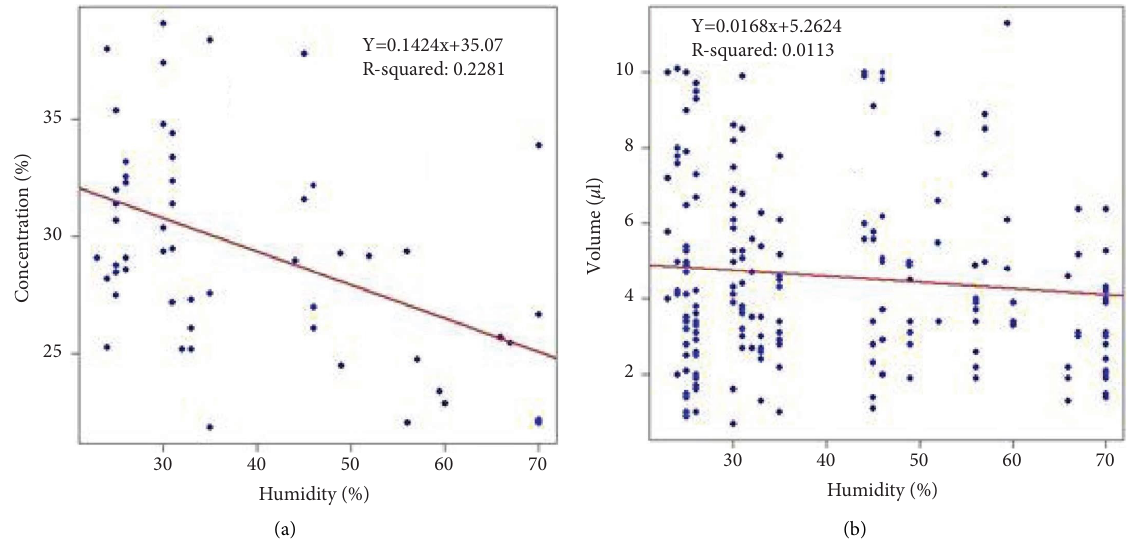
Figure 8: Efect of air humidity on nectar concentration (a) and volume (b) of S. leucantha